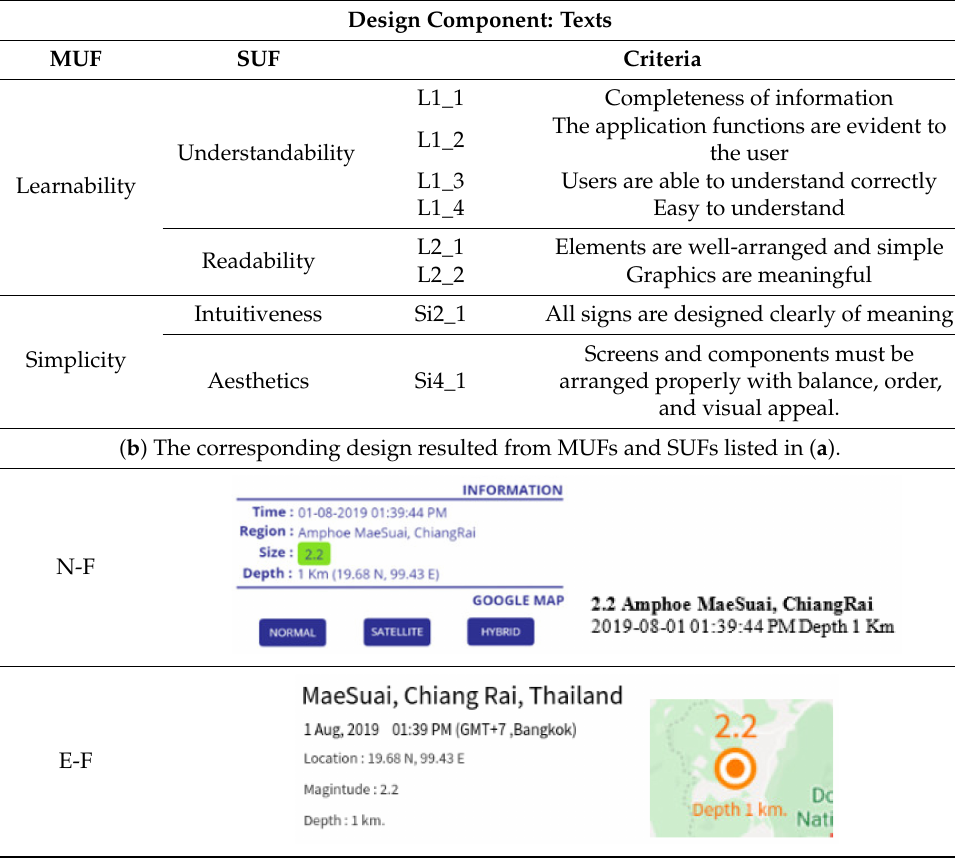
Table 8. ( a ) The usability design guideline for designing component “texts” and ( b ) the correspond- ing